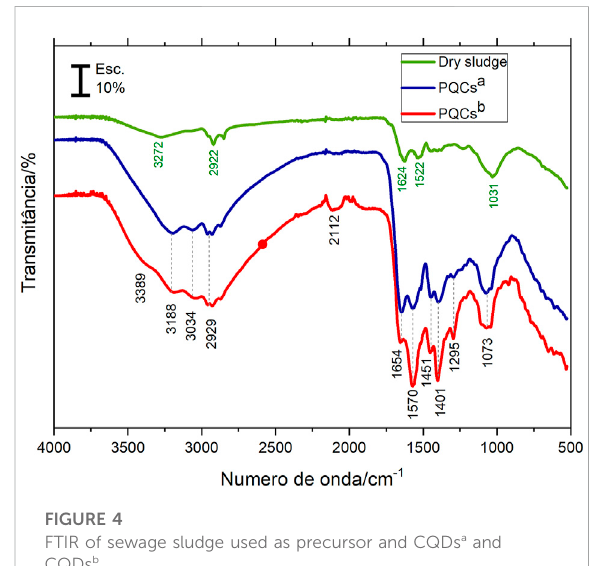
FIGURE 4 FTIR of sewage sludge used as precursor and CQDs a and CQDs b